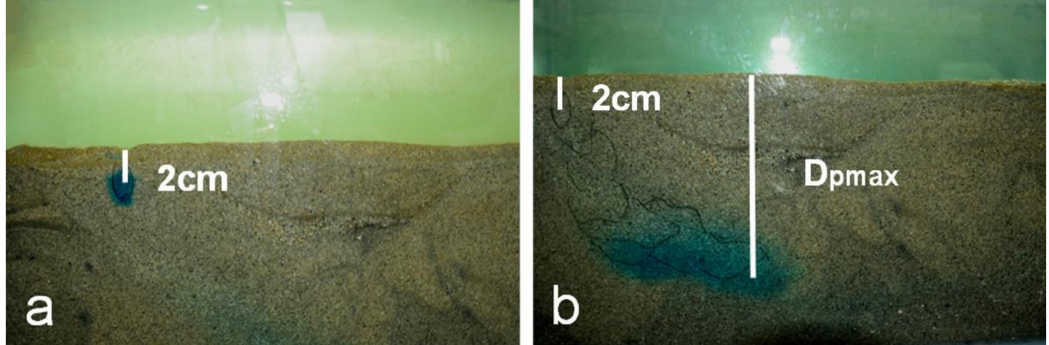
Figure 2. Flow path depicted on the flume wall, ( a ) distance from the dye injection point to the bed surface; ( b ) distance from the maximum penetration point to the bed surface. Here, one of the seven flumes for dye injection experiment was taken as an